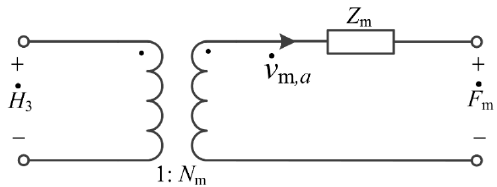
Figure 2. The equivalent circuit of the Terfenol-D layer.